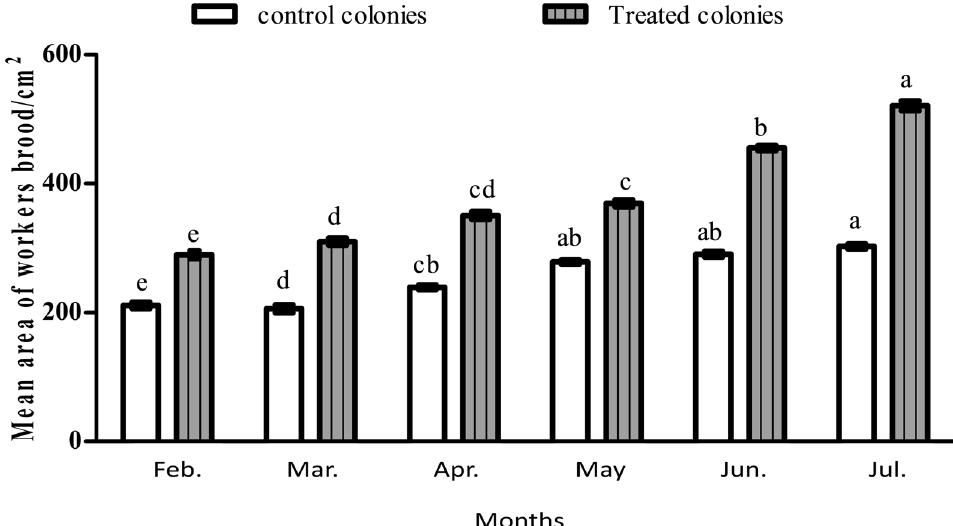
Fig. 1 The average ( SE) area of sealed workers brood/cm 2 in control and treated ±